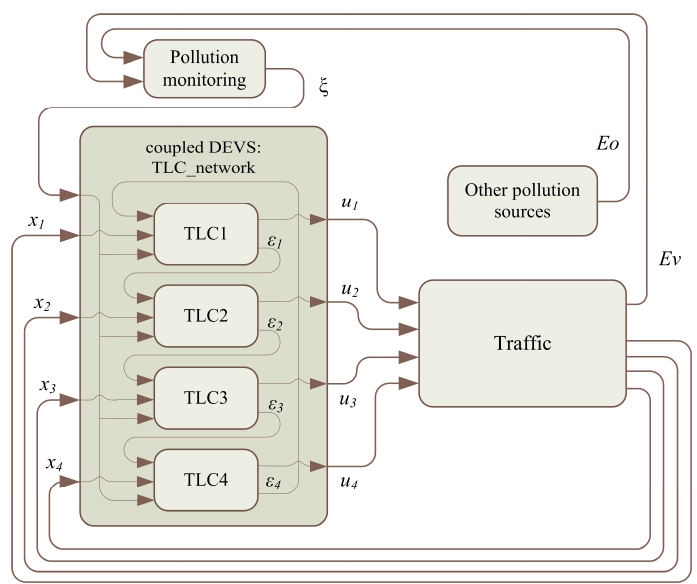
Figure 8. Schematic DEVS models for the test scenario.